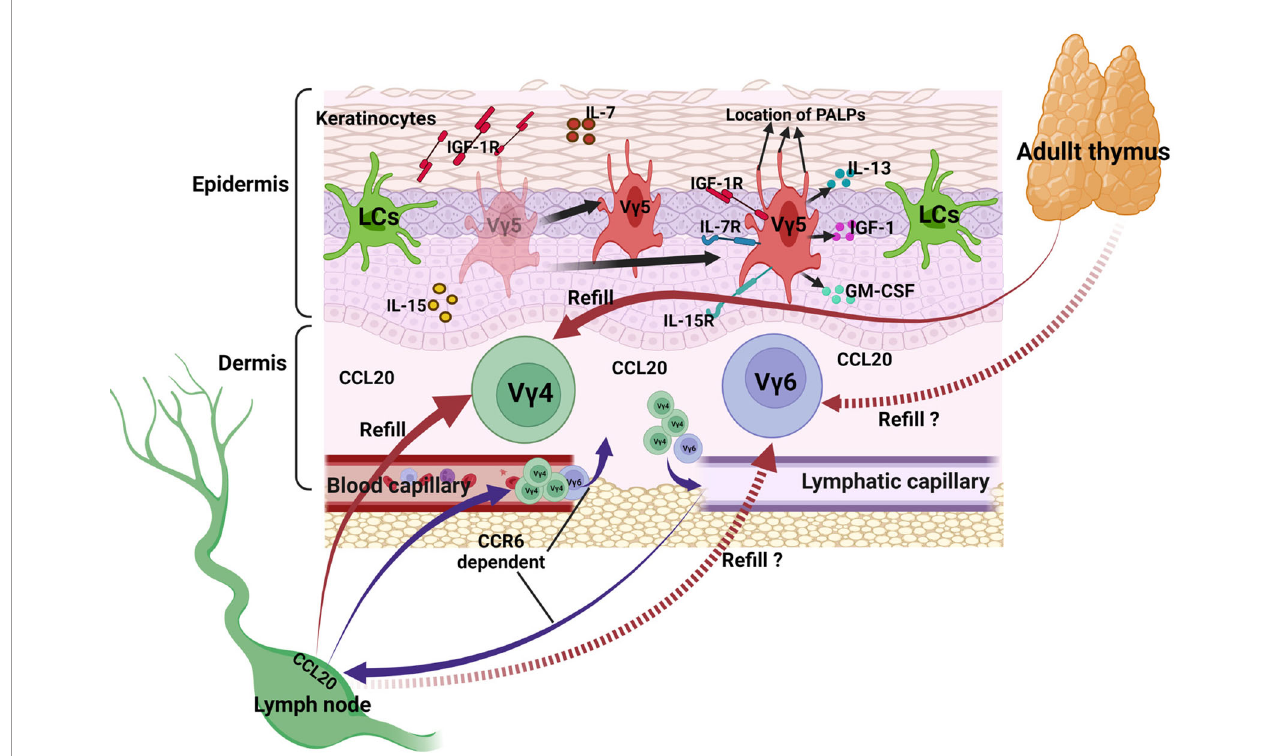
FIGURE 2 | gd T cells in maintaining skin homeostasis. DETCs in epidermis proliferate and maintain a homeostatic population by themselves, they secrete IL-13, IGF-1 and GM-CSF to help keeping steady state of themselves and other cells. IL-7 and IL-15 secreted by epithelial cells contribute to the survival and proliferation of DETCs, PALPs of the apically oriented dendrites contribute to the anchoring of DETCs to the keratinocyte junctions. V g 4 and V g 6 T subsets in the dermis traf fi c between tissues and lymph nodes at a slow but steady rate, CCR6 expressed on their surface combining with the CCL20 expressed in mucocutaneous sites and subcapsular region of primate LNs is an important